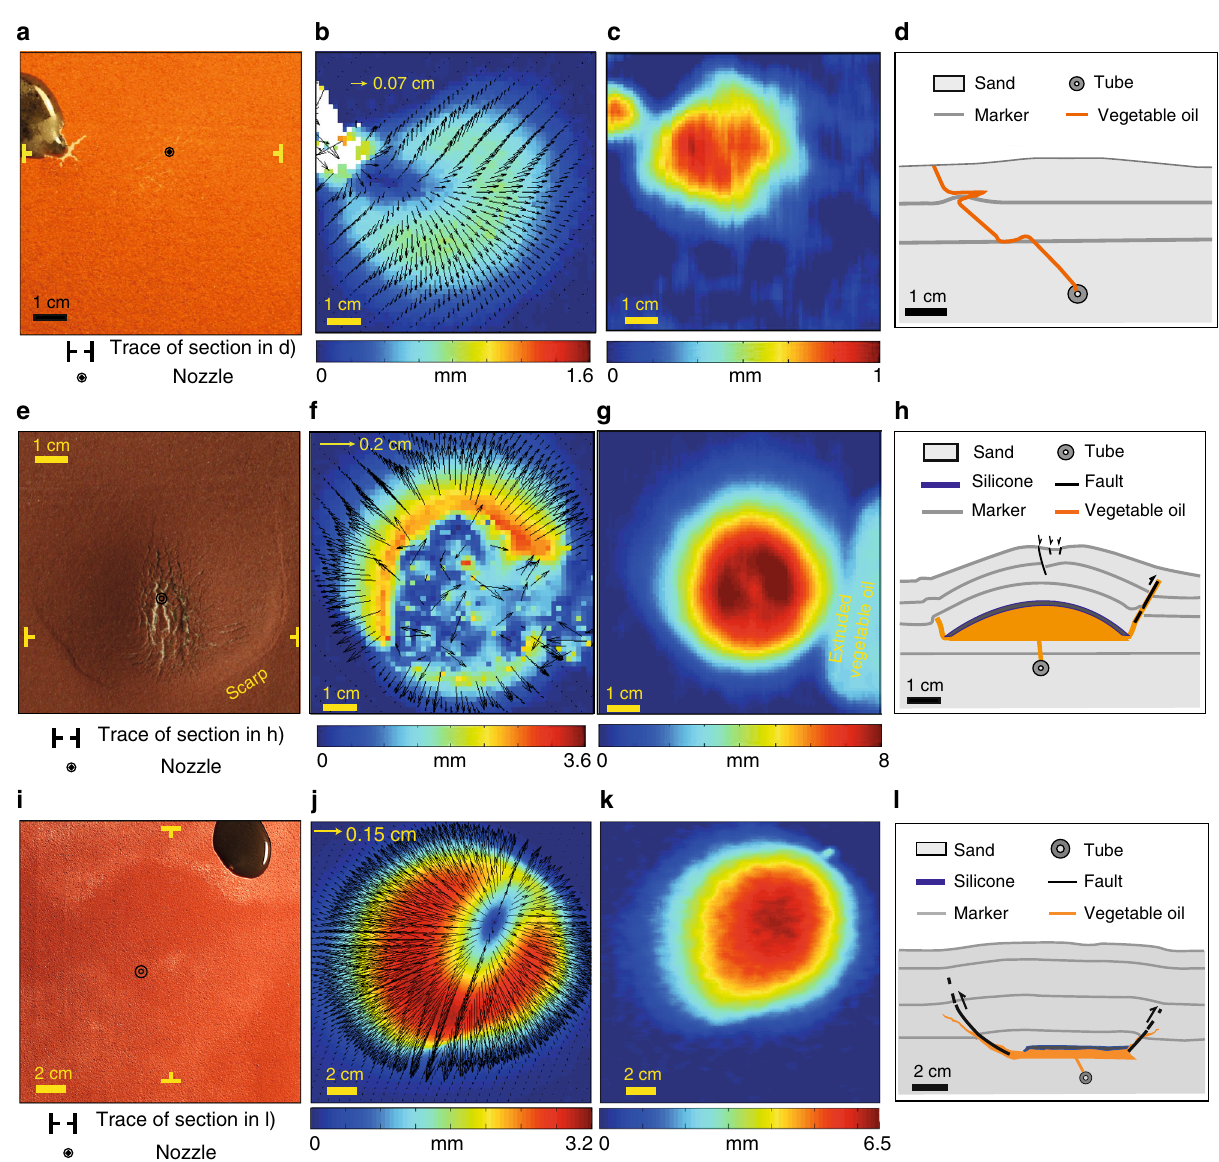
Fig. 4 Analogue models. a Map view of an experiment (RIS 1; Supplementary Table 2) without silicone layer, showing the extrusion of the oil within the sand ( t = 60 s); a minor deformed area lies to the right of the extrusion point. b Cumulative horizontal displacement of the model; colour scale and arrows are proportional to the amount of displacement. c Cumulative vertical displacement; colour scale is proportional to the amount of uplift. d Section of the experiment (trace in a ), showing a dike with dip of ~46°, partly de fl ected along the marker levels. e Map view of an experiment (RIS 5; Supplementary Table 2) with shallower (1.5 cm) silicone layer ( t = 45 s): a dome with apical graben is bordered by a ring scarp. f Cumulative horizontal displacement of the model. g Cumulative vertical displacement. h Section of the experiment (trace in e ) with a reverse fault, intruded by the oil, at the periphery of a laccolith. i Map view of an experiment (RIS 9; Supplementary Table 2) with deeper (6 cm) silicone layer ( t = 240 s): a dome is accompanied by the extrusion of oil at its upper right edge. j Cumulative horizontal displacement of the model. k Cumulative vertical displacement. l Section of the experiment (trace in i ) with a reverse fault, intruded by the oil, at the periphery of a sill. Same colours in the scales of the experiments may refer to different deformation